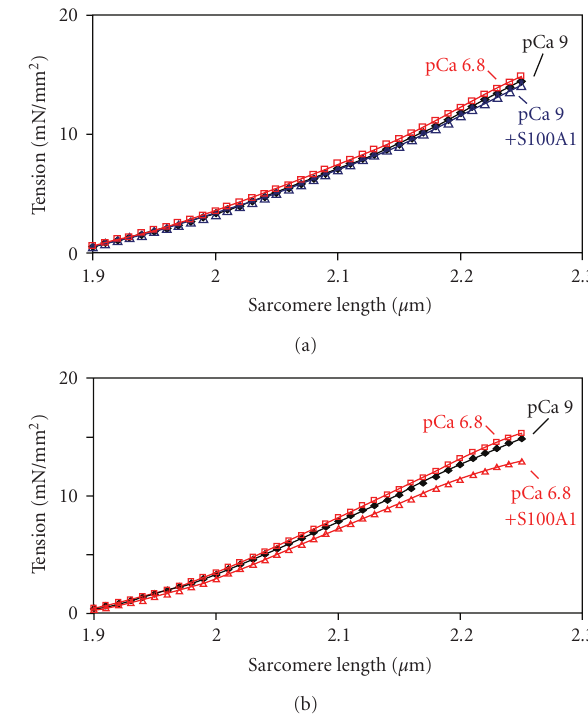
Figure 4: Hysteresis before and after gelsolin treatment. (a) Protocol. Skinned muscles were stretched to a given length followed by a release back to slack and hysteresis was calculated from the area of the resultant force-sarcomere length curve. Measurements were made before and after gelsolin treatment. (b) Comparison of hysteresis at SL 2.25 μ m with % hysteresis reduction. All tissues showed an increase in hysteresis with SL and a reduction in hysteresis following actin extraction with gelsolin. Error bars are SE. ∗ P < . 01.